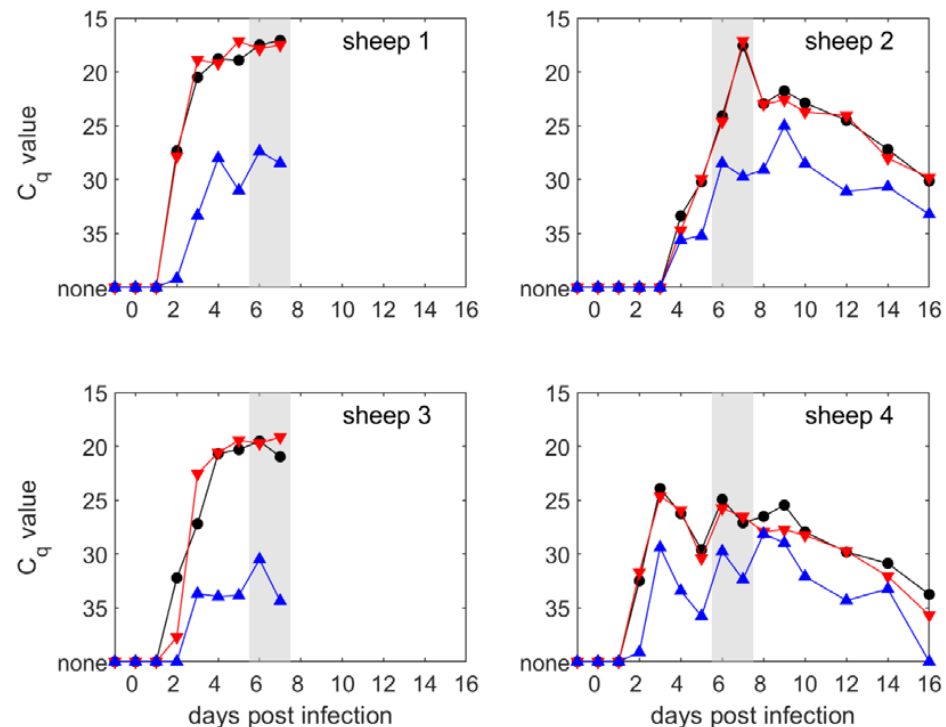
Figure 2. Levels of viremia (measured by rRT-PCR) in sheep co-infected with BTV-1 and BTV-8. Each plot shows the C q values for the detection assay (black circles), the BTV-1 typing assay (red down-triangles), and the BTV-8 typing assay (blue up-triangles). The grey shaded areas indicate when uninfected Culicoides sonorensis were fed on the sheep.